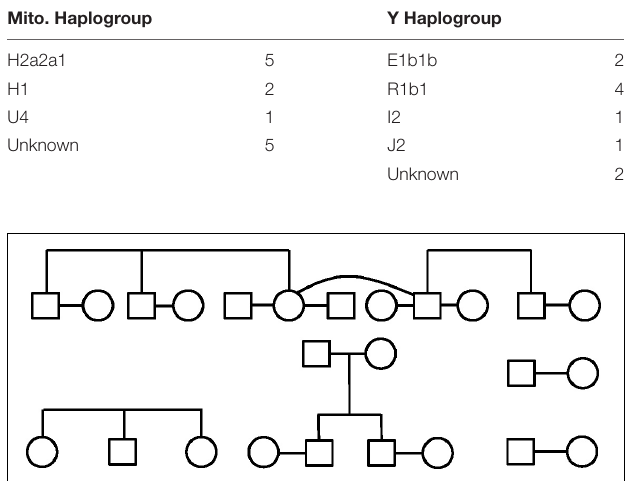
FIGURE 3 | The familial relationships of the founders of Robinson Crusoe Island, who were identified by genealogical analysis, and are directly related to the present day population (Villanueva et al., 2008, 2011, 2014, 2015a). Males are indicated by a square, and females indicated by a circle.